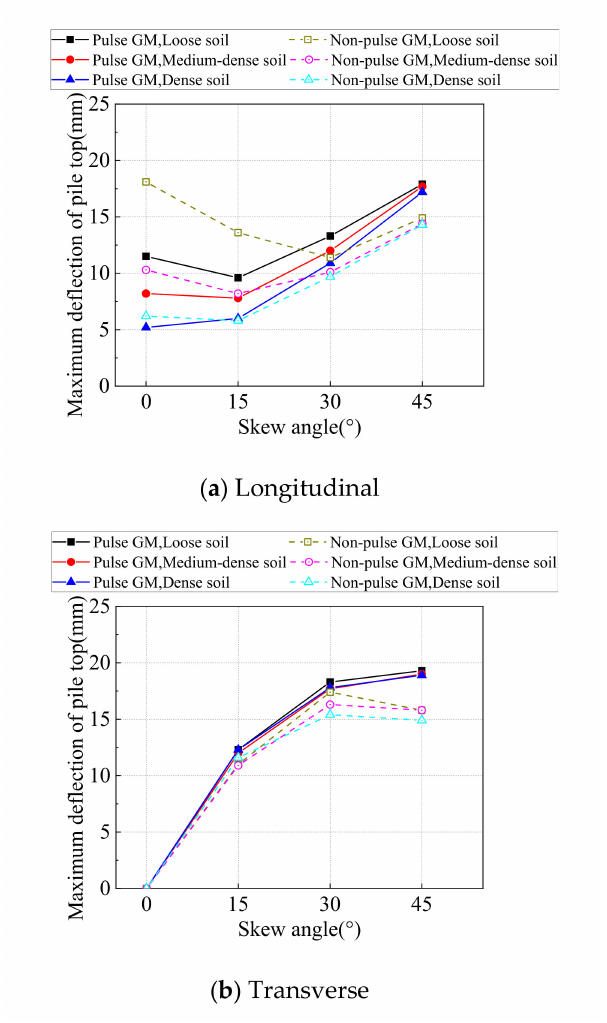
Figure 16. Maximum deflection of the pile